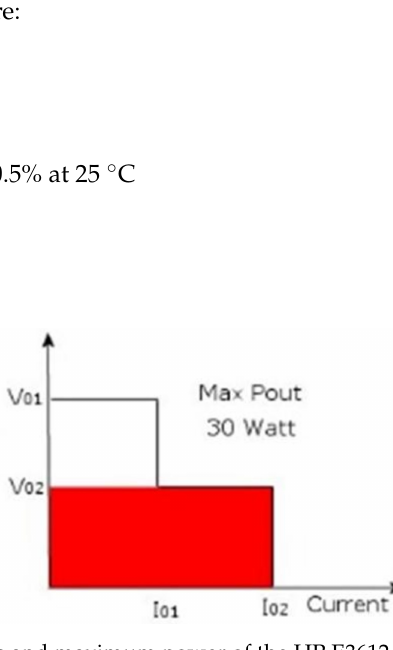
Figure 2. Features and maximum power of the HP E3612A power